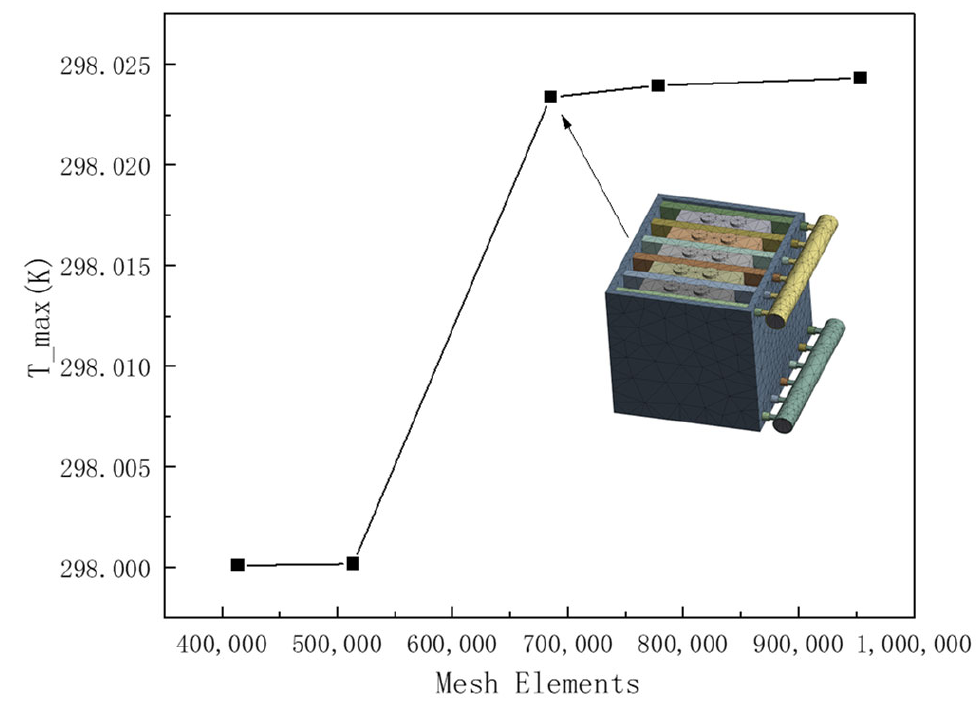
Figure 2. Grid independence verification.